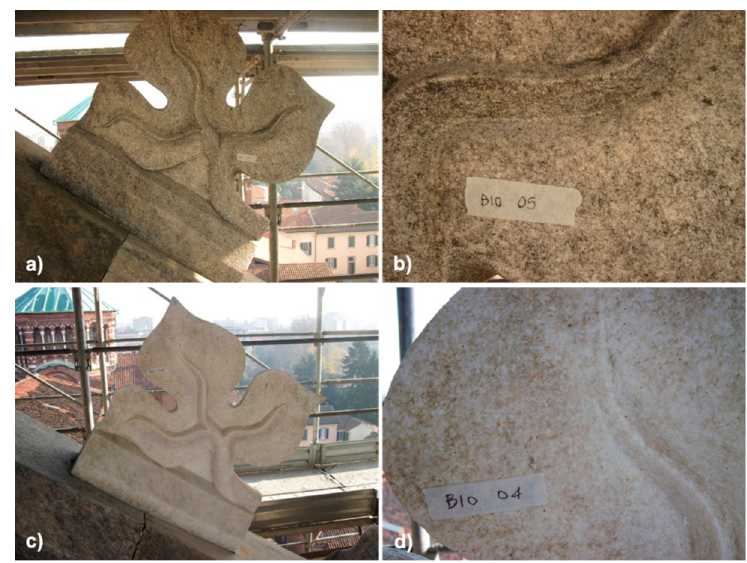
Figure 1. Photographic documentation of the Candoglia untreated ( a ) and treated ( c ) leaves, and details of the sampling areas untreated and treated areas ( b – d ) respectively.